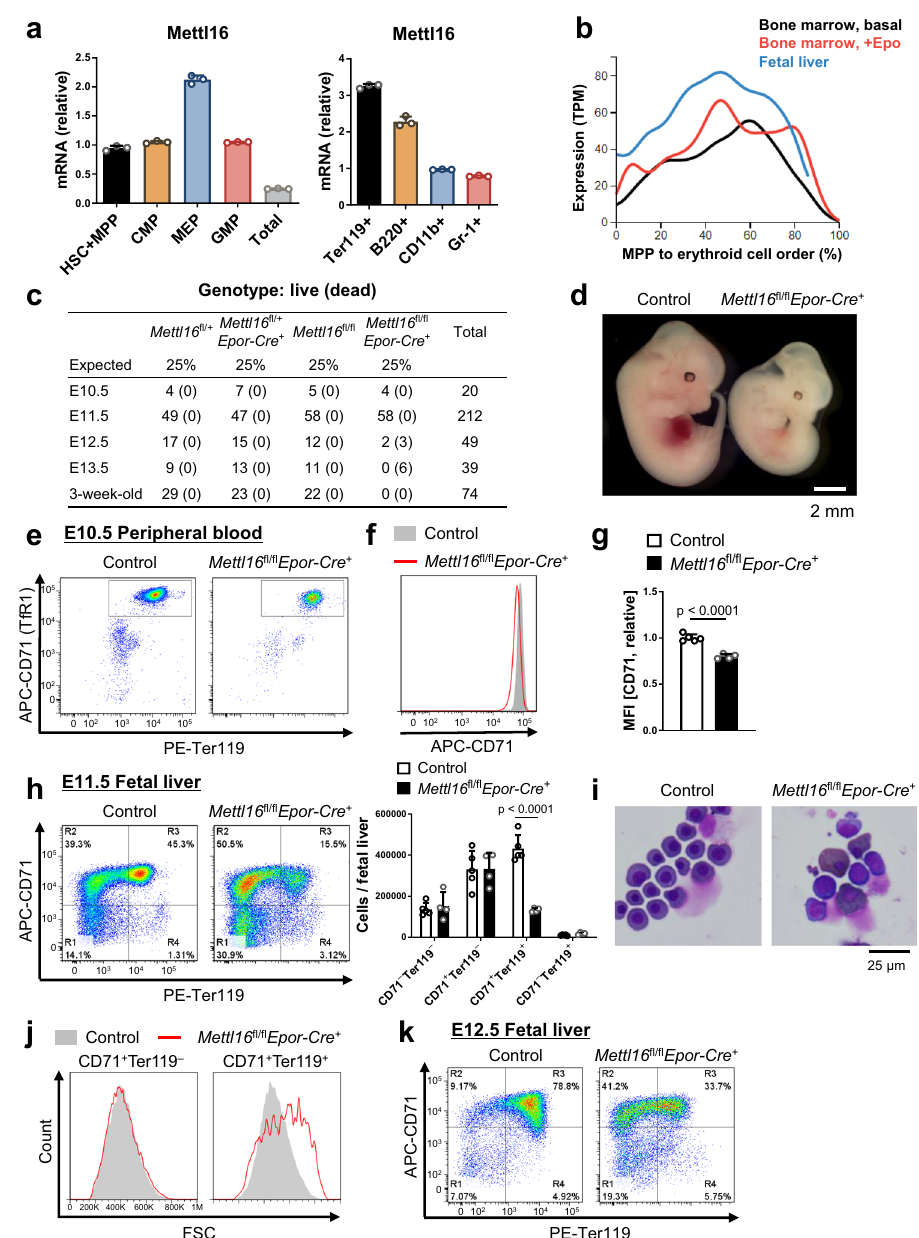
Fig. 2 | RNA methyltransferase METTL16 regulates erythroid differentiation in vivo. a Mettl16 mRNA expression levels in each hematopoietic compartment ( n =3 technical replicates). HSC hematopoietic stem cells, MPP multipotent pro- genitors, CMP common myeloid progenitors, GMP granulocyte-monocyte pro- genitors,MEPmegakaryocyte-erythrocyteprogenitors. b Geneexpressionpatterns of Mettl16 mRNA during erythroid differentiation generated from the single-cell RNA-seq analysis 48 . c Survival rates of mice with each genotype. d Fetuses on E12.5 of control and Mettl16 fl / fl Epor-Cre + mice. e – g Flow cytometric analysis of the E10.5 peripheralbloodfrom Mettl16 fl / fl Epor-Cre + mice( e ).ThehistogramofCD71intensity